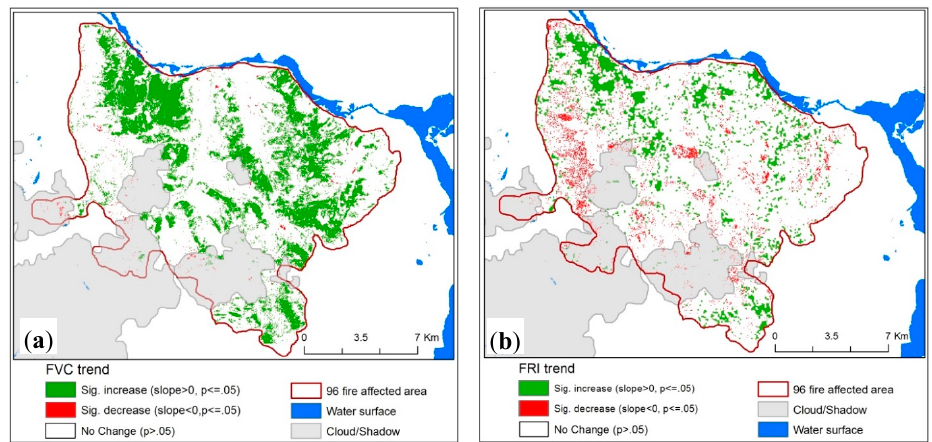
Figure 3. Post ‐ fire Larch forest patterns estimated using FVC slope and its p ‐ value, an indicator of occupation rate of post ‐ fire vegetation cover—early successional stage ( a ); and the slope of the FRI trend and its p ‐ value, an indicator of Larch forest recruitment—later successional stage ( b ). The continuous values of both FVC and FRI slopes were extracted and used as response variables in modeling post ‐ fire forest patterns.